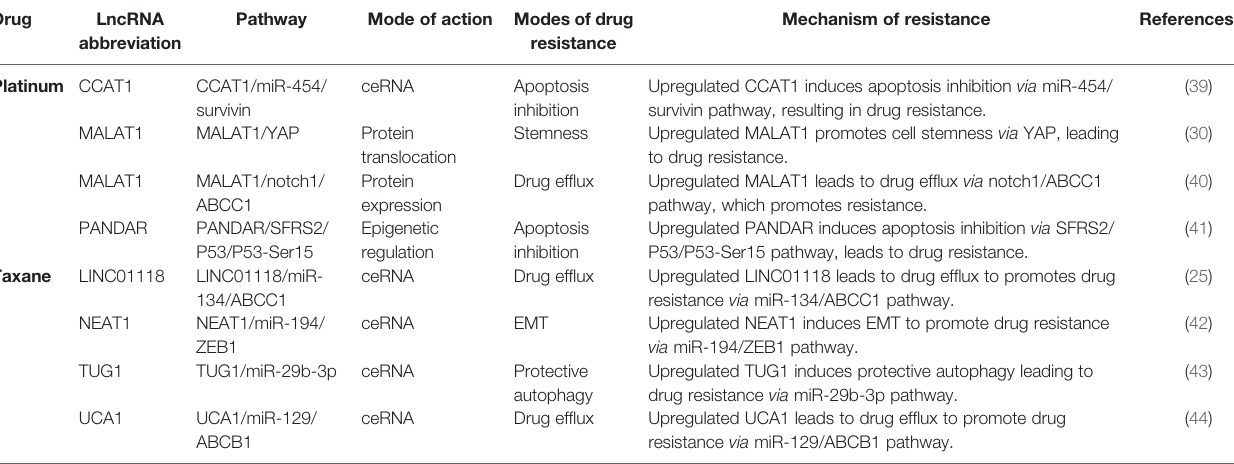
TABLE 1 | Drug resistance in ovarian cancer caused by the ectopic expression of lncRNA.